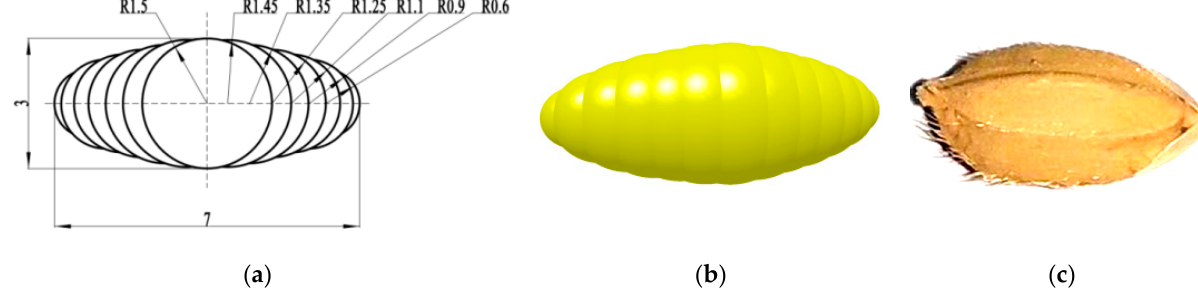
Figure 3. Rice particle simulation: ( a ) particle size; ( b ) particle model; ( c ) rice grain.